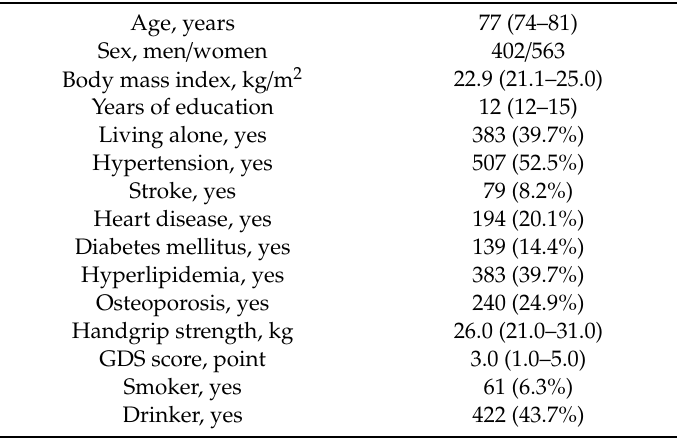
Table 1. Characteristics of study